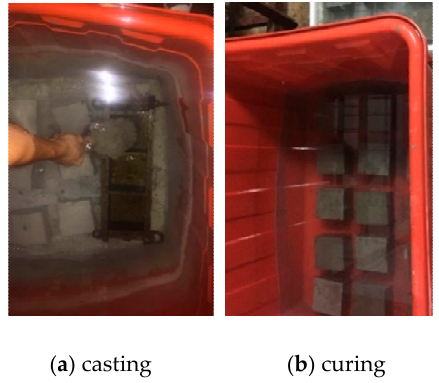
Figure 3. Production process of specimens.